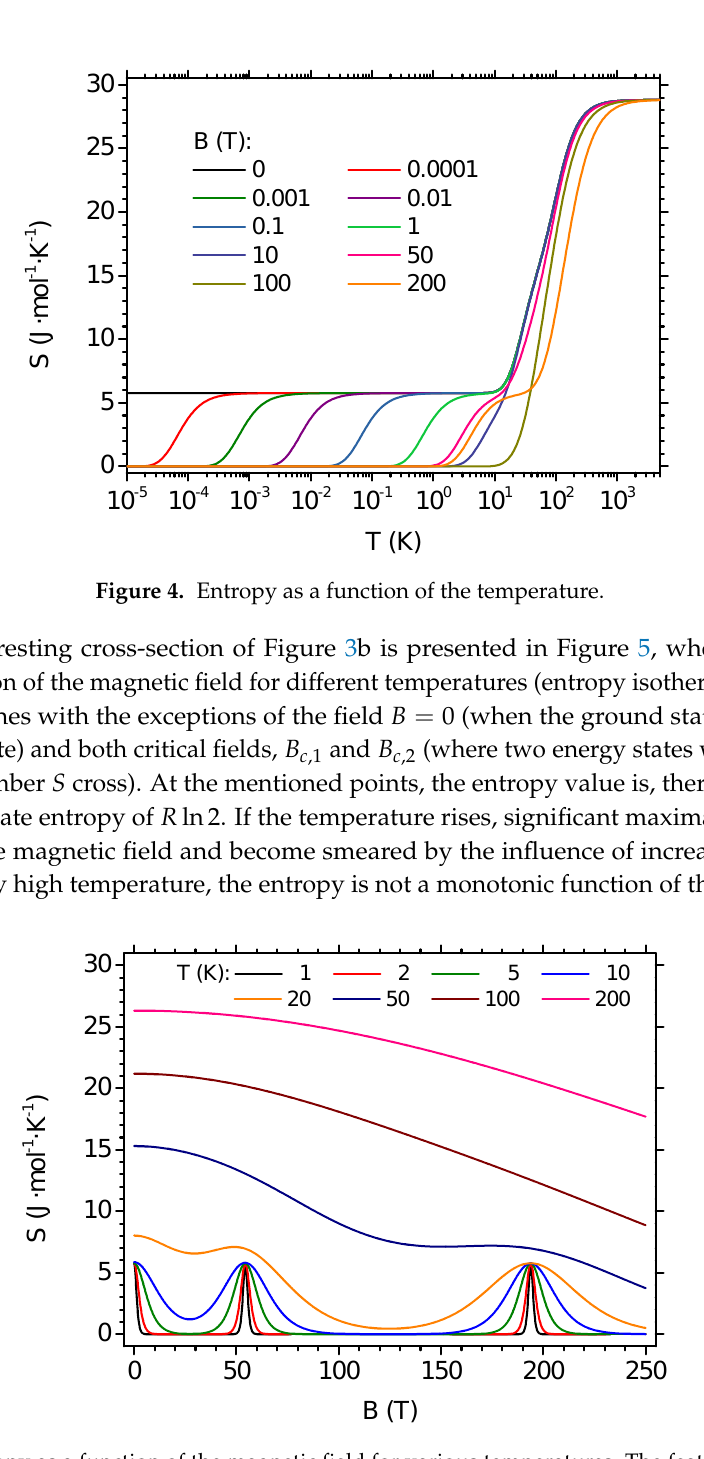
Figure 5. Entropy as a function of the magnetic field for various temperatures. The features are visible in the vicinity of the quantum level crossings—for detailed discussion and critical field values, see Appendix